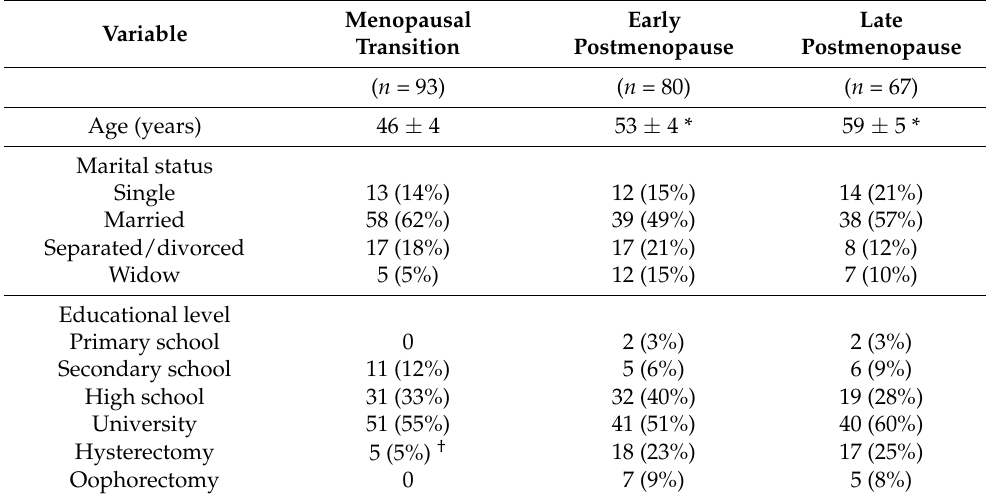
Table 1. Description of study groups.